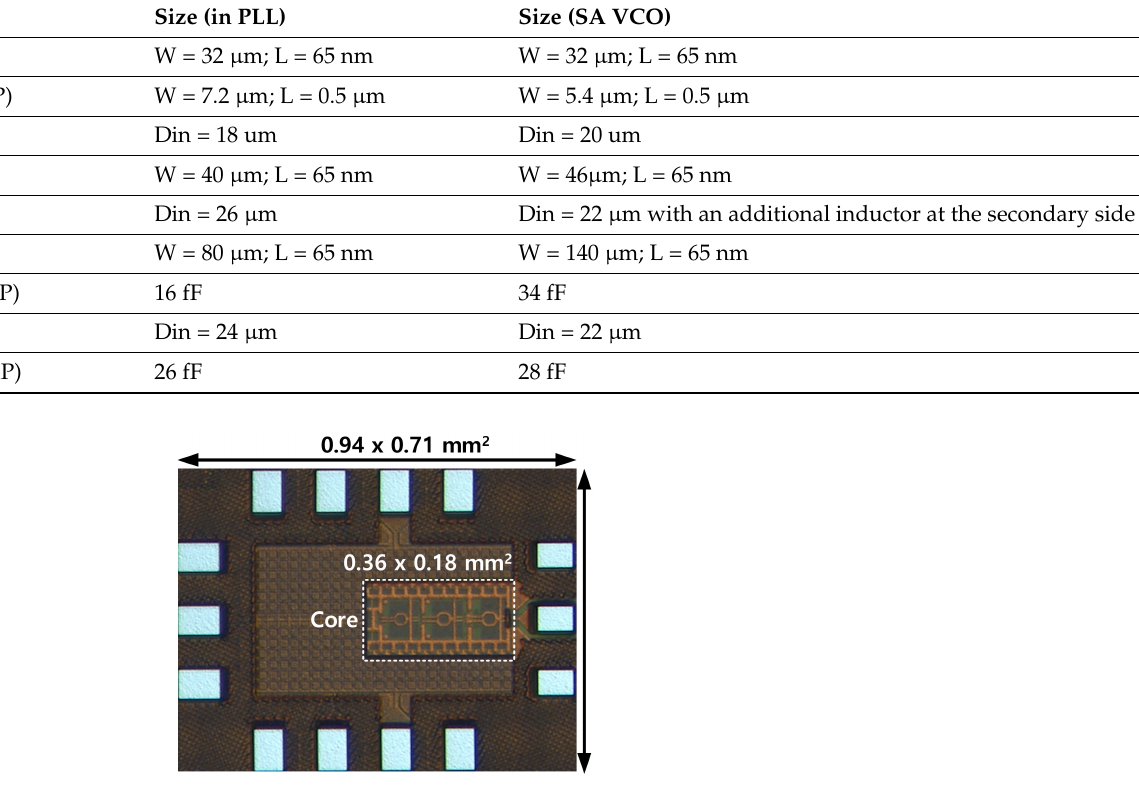
Figure 9. A photograph of the standalone VCO fabricated in 65-nm